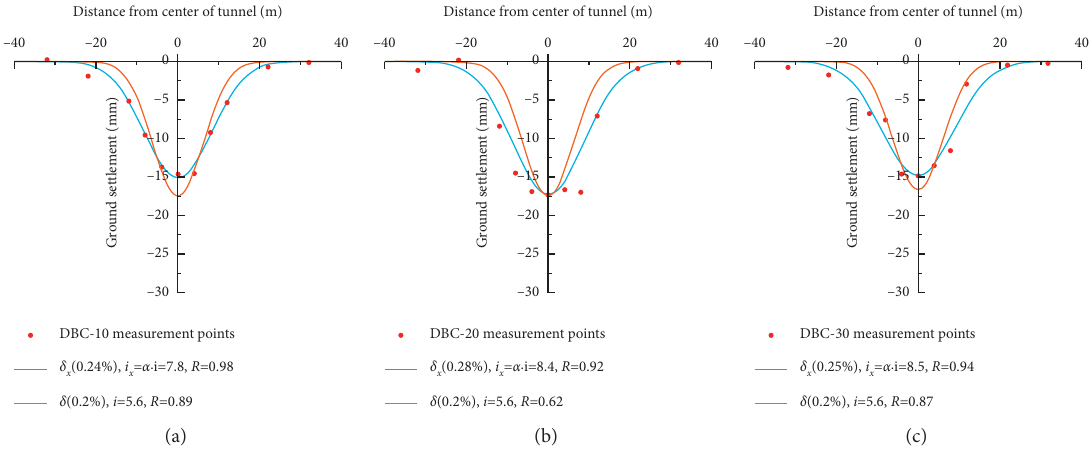
Figure 17: Field measurement and Peck formula optimization of pipe jacking ground surface settlement: (a) DBC-10. (b) DBC-20. (c) DBC- 30.